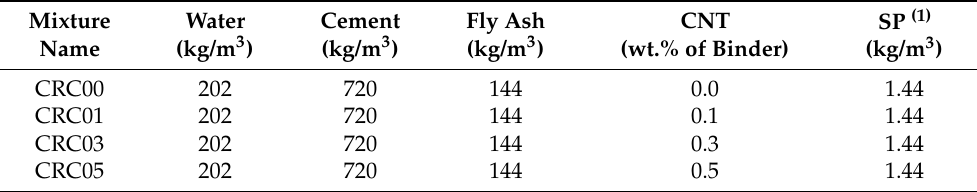
Table 2. Mixture proportions of CNT-reinforced cementitious composites.